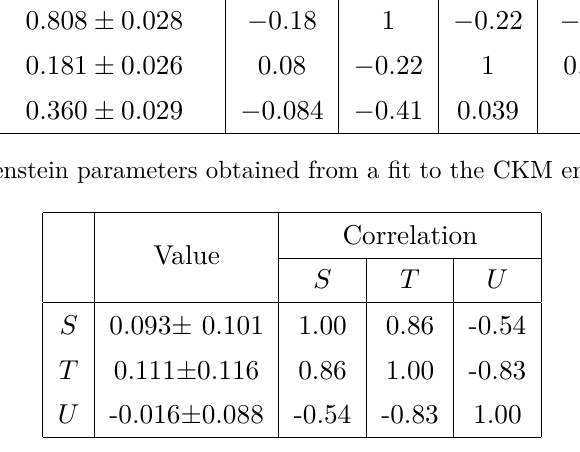
Table 6 . Results for the fit of the oblique parameters S , T and U , excluding the information from R b